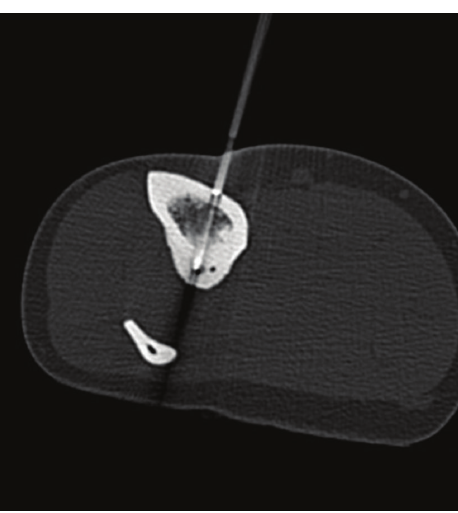
Figure 3: Positioning the radiofrequency probe under CT